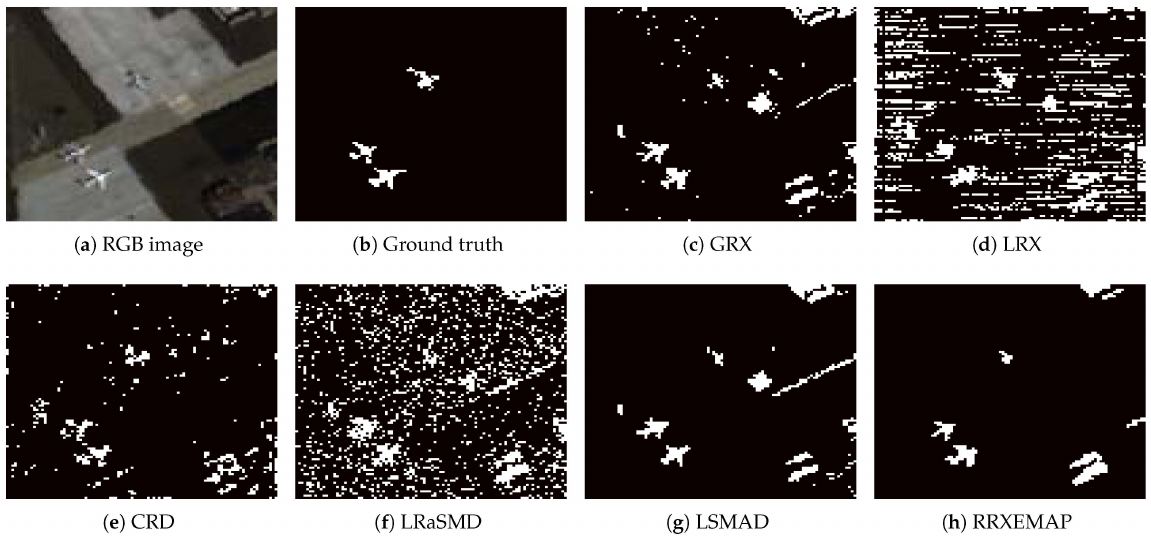
Figure 8. Color detection maps obtained by different algorithms for the AVIRIS-II dataset.